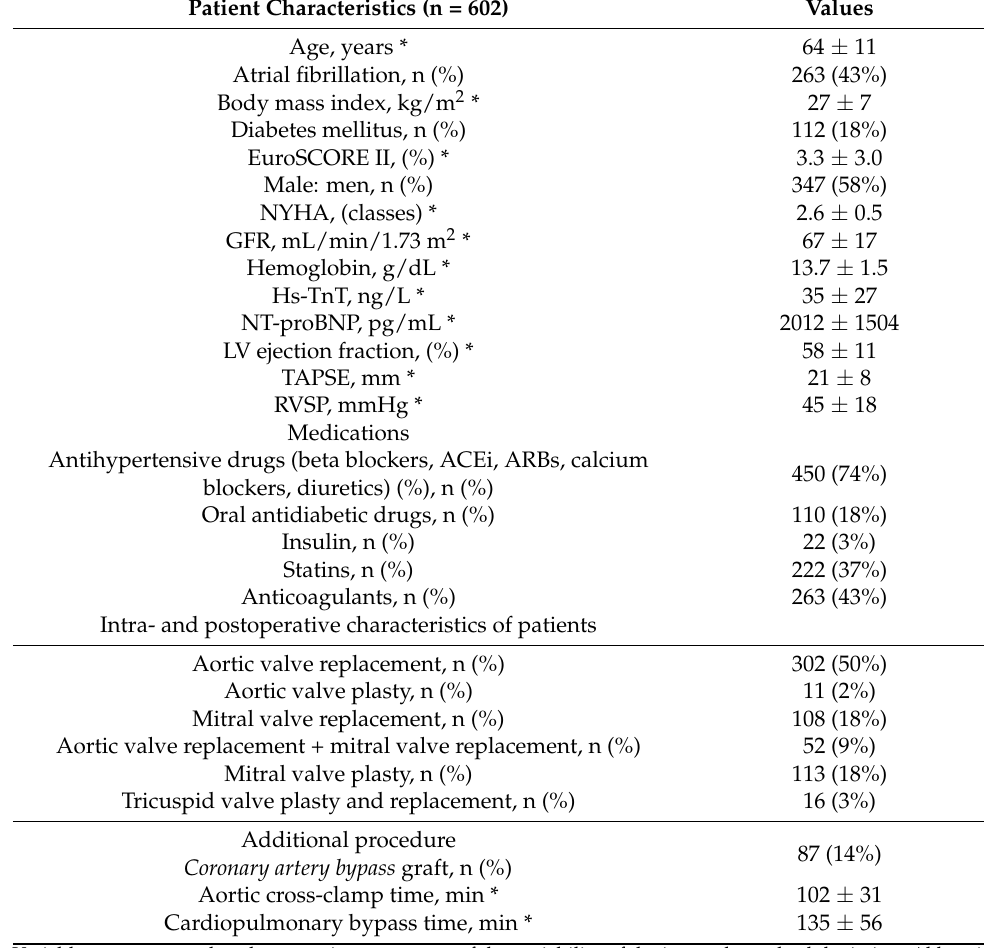
Table 1. Characteristics of the entire study